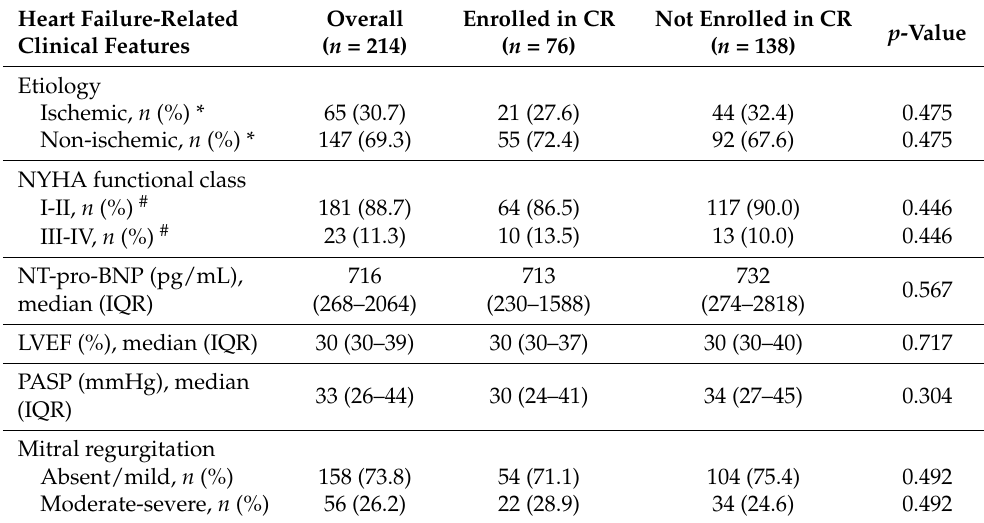
Table 2. Heart failure-related clinical features of the studied population according to participation